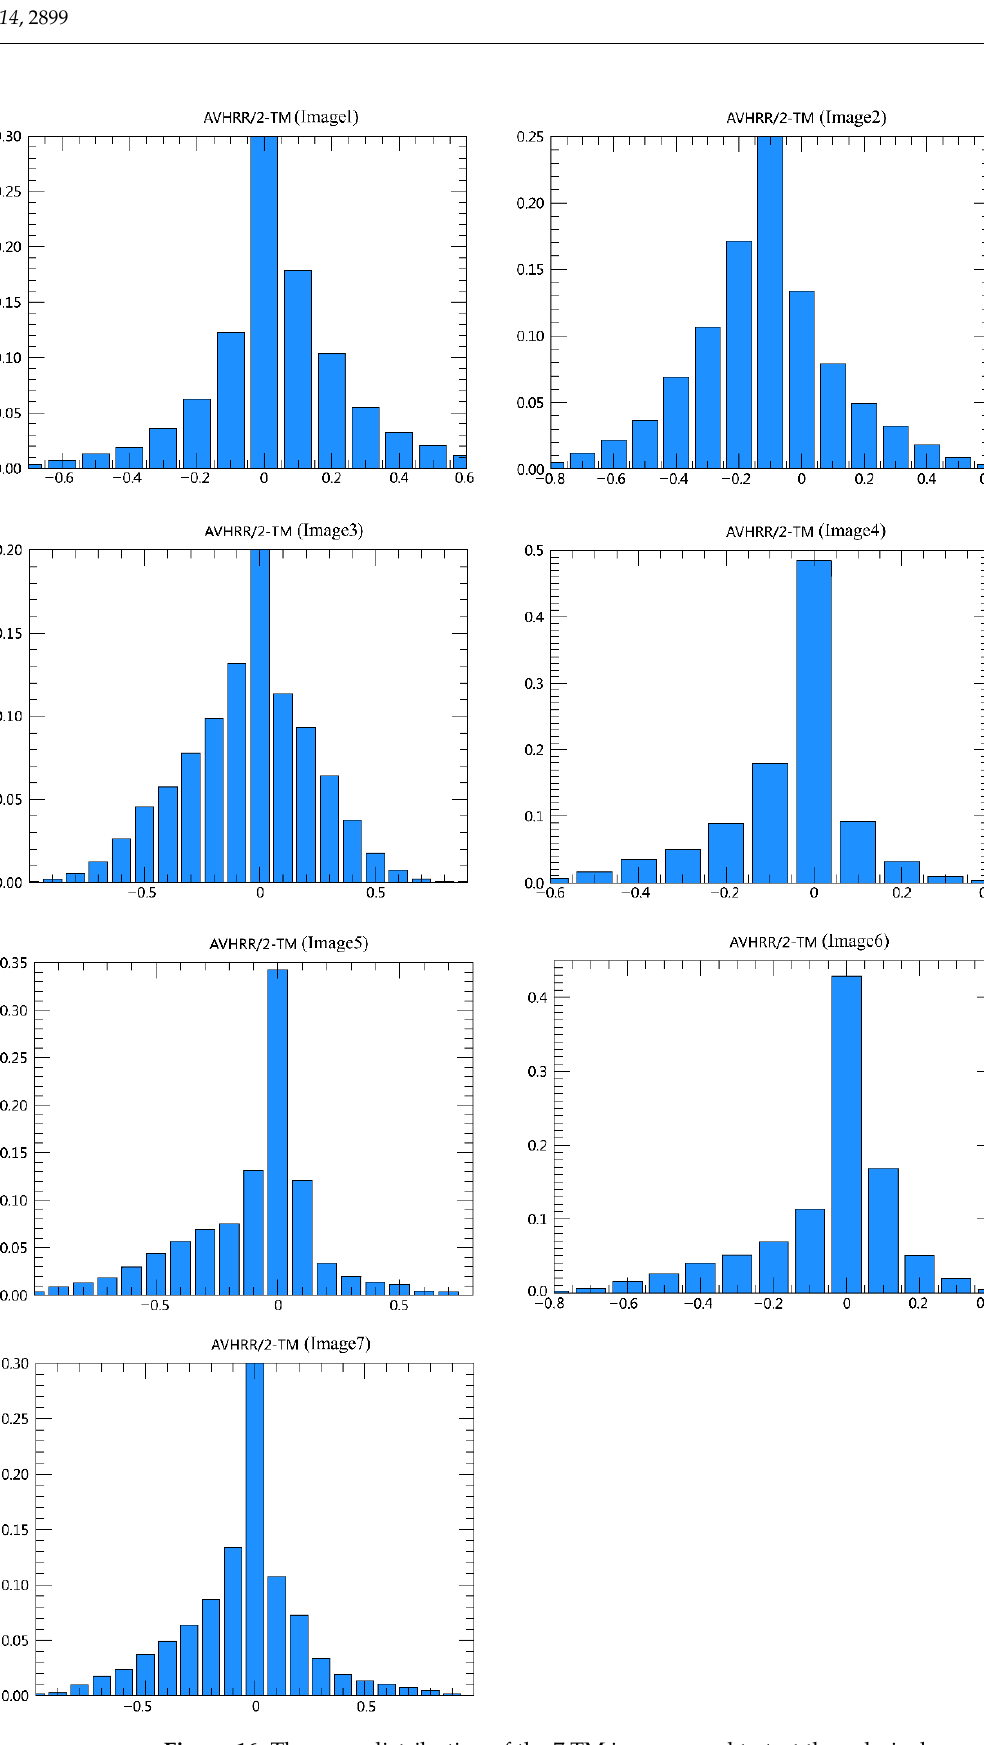
Figure 16. The error distribution of the 7 TM images used to test the subpixel snow mapping.